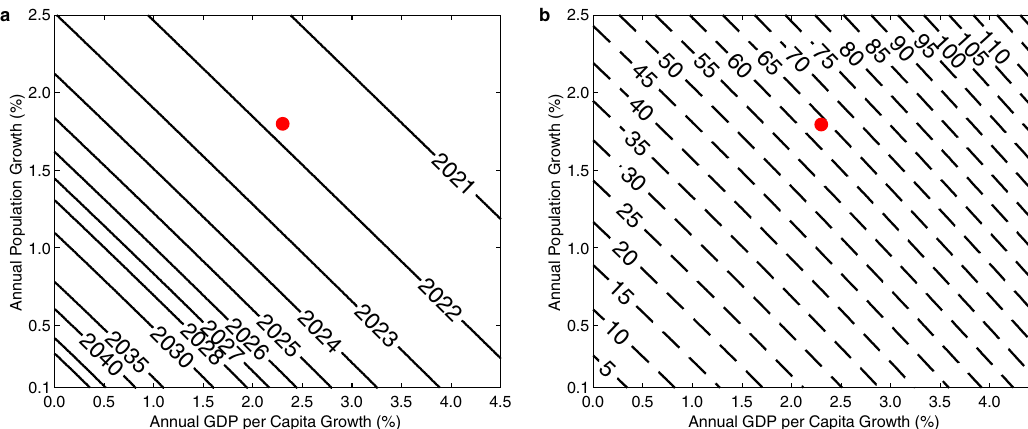
Fig. 5 Future projection of demand. a Projected Year that Virtual Water Imports will Reach 61.5 km 3 with population increase and GDP per capita increase. Future increases in demand are added to the Hindcast (model) estimate of total demand minus total estimated Nile use. The red dot marks the nominal scenario of 1.7% population growth and 2.3% GDP per capita growth. b Additional virtual water (km 3 ) needed in 2030 to satisfy increased demand (i.e. projected virtual water Imports in 2030 values minus 2017 virtual water import amount). The red dot marks the nominal scenario of 1.7% population growth and 2.3% GDP per capita